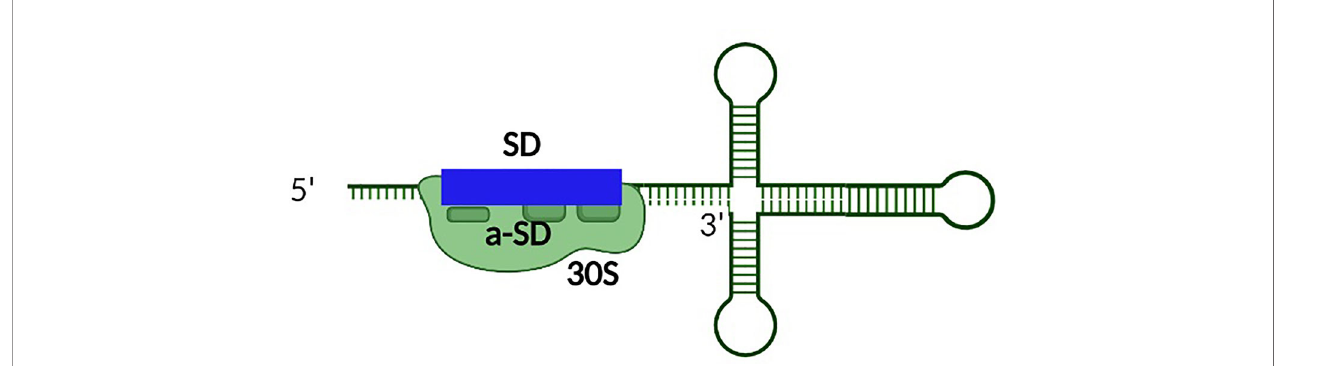
FIGURE 7 | The presence of perfect complementarity between the SD site of the toxin transcript and the anti-SD sequence within the rRNA represses the production of some Type I toxins. Unusually tight binding between the SD site and anti-SD site within the rRNA of the ribosome reduces toxin production by inducing